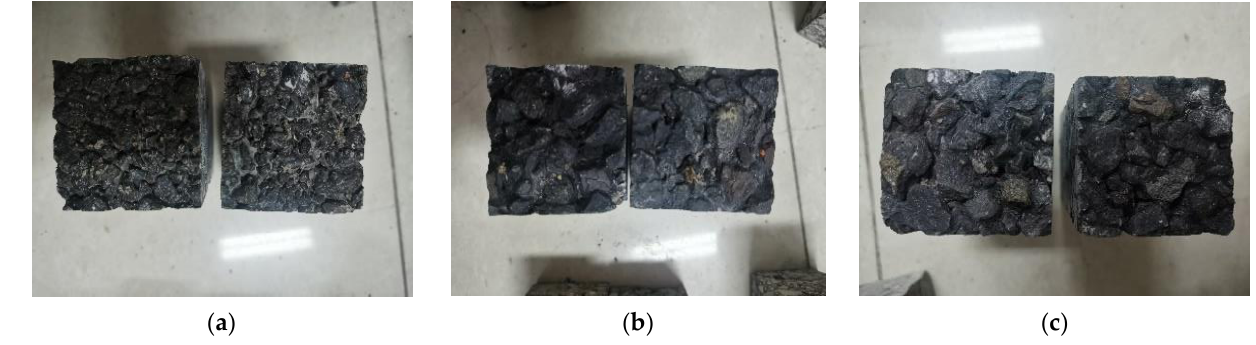
Figure 10. Specimen surfaces after the accelerated loading test. ( a ) I-6; ( b ) II-1; ( c ) II-3.